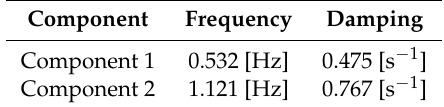
Table 2. Estimates of oscillations parameters of Kundir’s